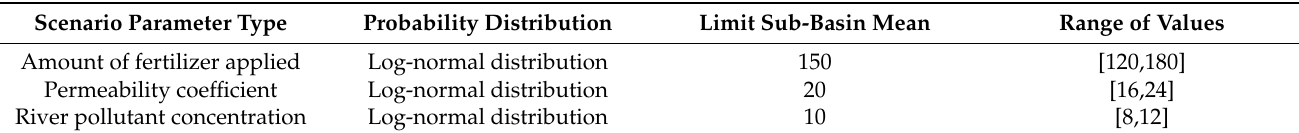
Table 5. Probability distribution and value range of scenario parameters.